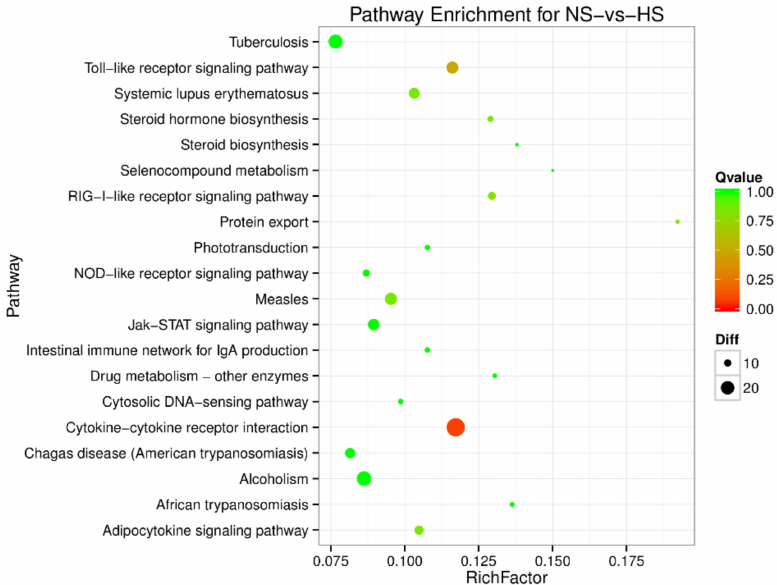
Figure 4. Pathway enrichment analysis of di ff erentially expressed miRNA target genes for normal (NS)-vs-heat stress (HS). The larger circle area means the more di ff erently expressed gene number. The Q value represents a significant level ( p -value <